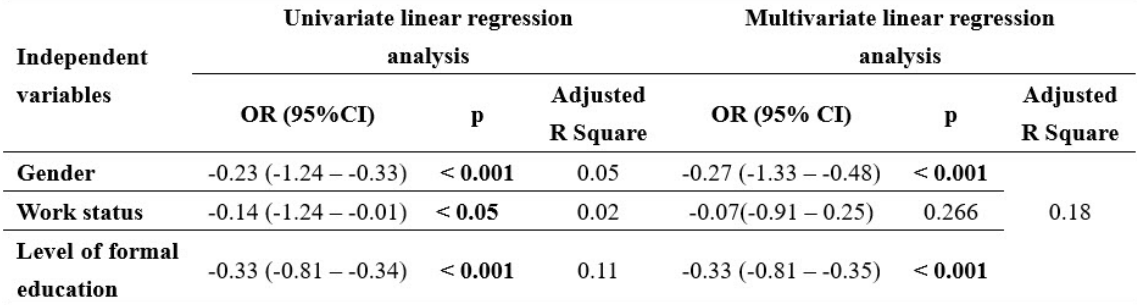
OR-odds ratio, p - statistical